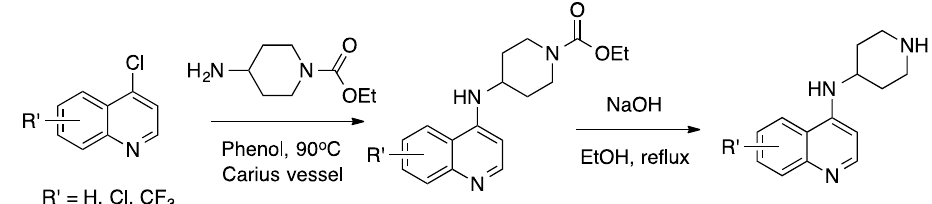
Figure 6. Synthesis of one starting material for unsymmetrical bisquinoline compounds.